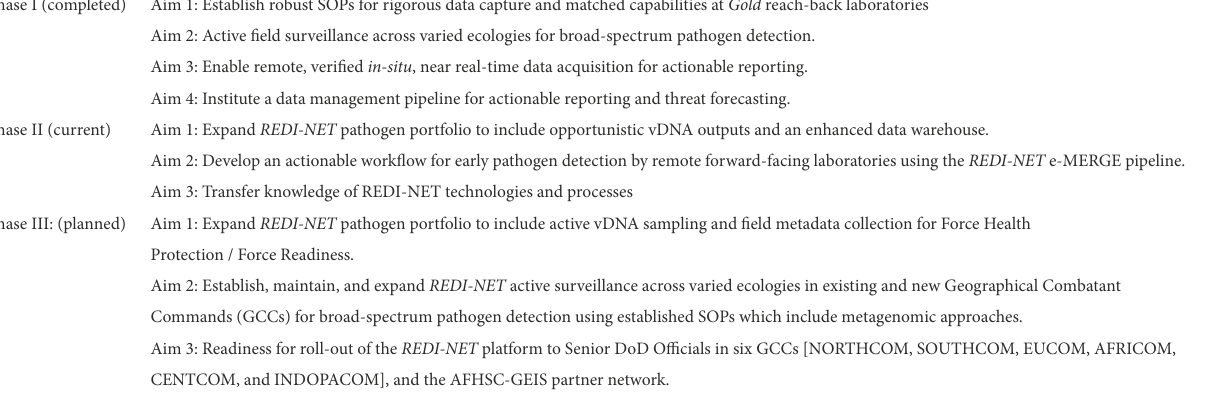
TABLE 1 REDI-NET program